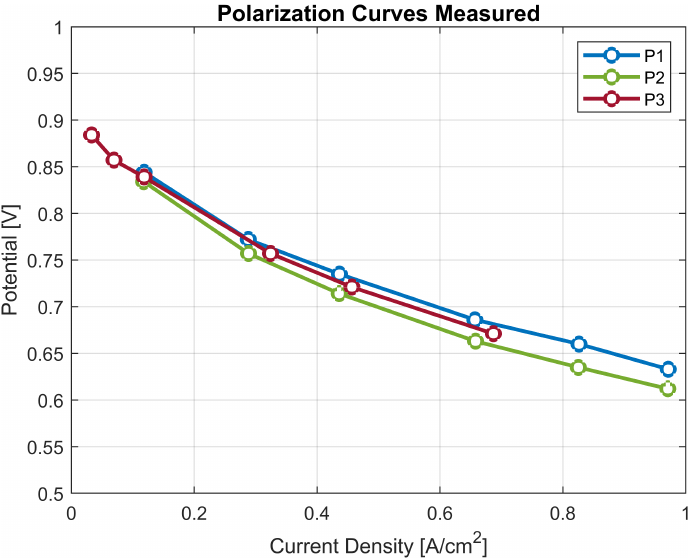
Figure 2. Measured polarization curves for different anode pressures and cooling inlet